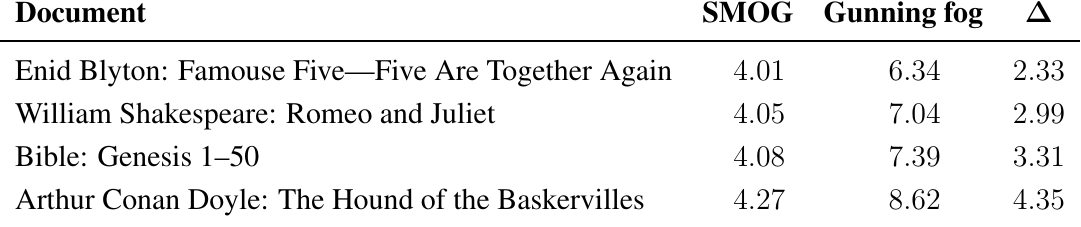
Table 1. Absolute difference ∆ between SMOG and Gunning fog values for selected